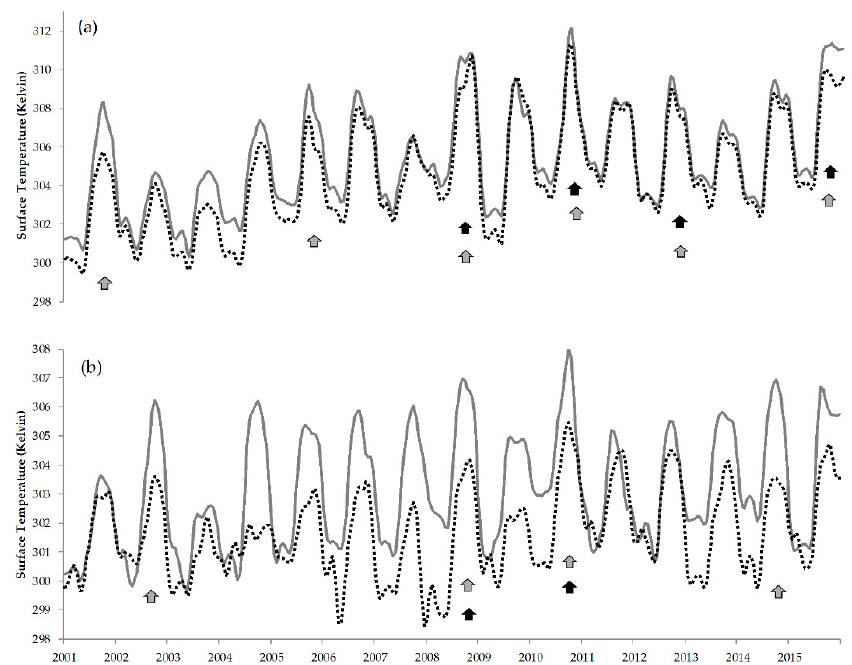
Figure 12. Time series of Land Surface Temperature in the Ji-Paraná River Basin, considering: ( a ) pastures, with four (dotted line) and eight (gray line) years of fire; and ( b ) Altered Ombrophilous Forest, with two (dotted line) and four (gray line) years of fire ( b ). Arrows indicate the exact dates of fires in these pixels, black arrow for dotted line and gray arrows for the gray line.